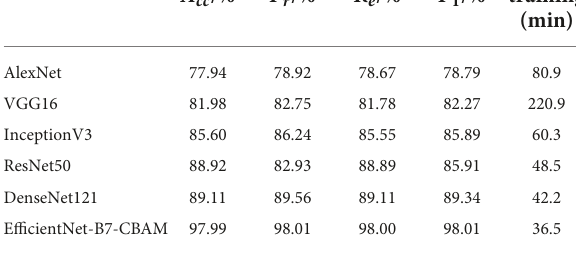
TABLE 4 Performance comparison with other models.